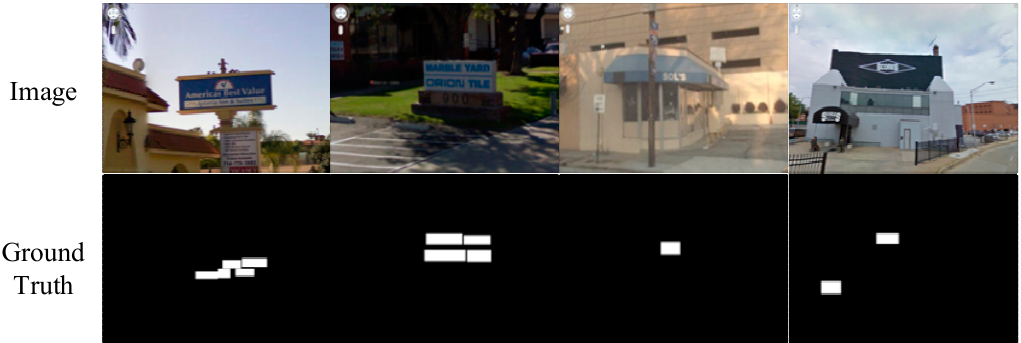
Figure 9. Examples of the Street View Text (SVT) dataset. Text with lower resolution, complex light